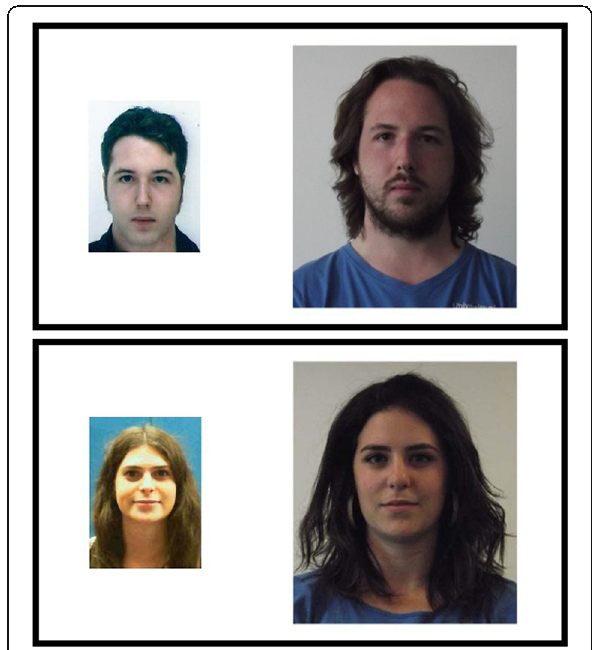
Fig. 2 Example stimuli from the Kent Face Matching Test (KFMT; Fysh & Bindemann, 2018). The top pair depicts an identity match, whereas the bottom pair depicts an identity